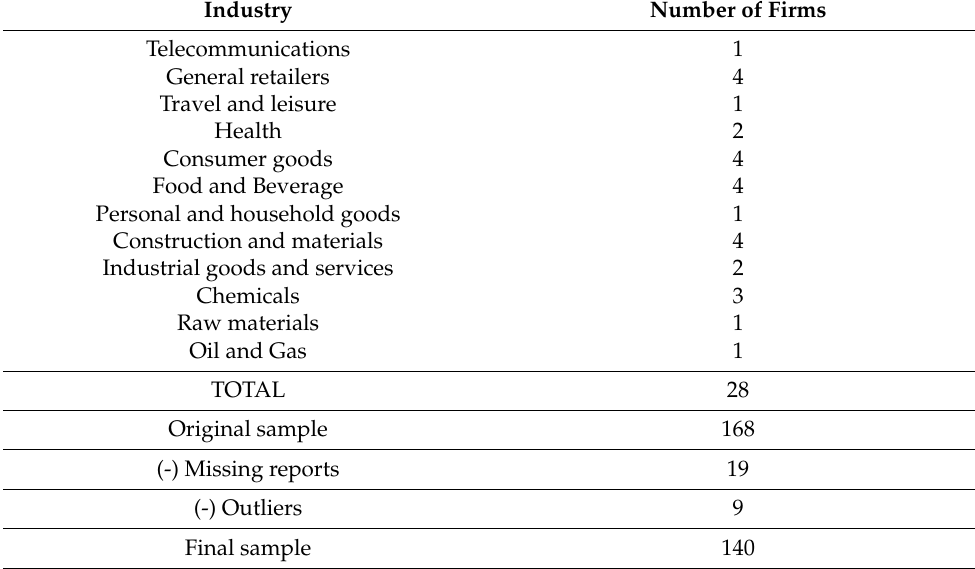
Table 1. Industries’